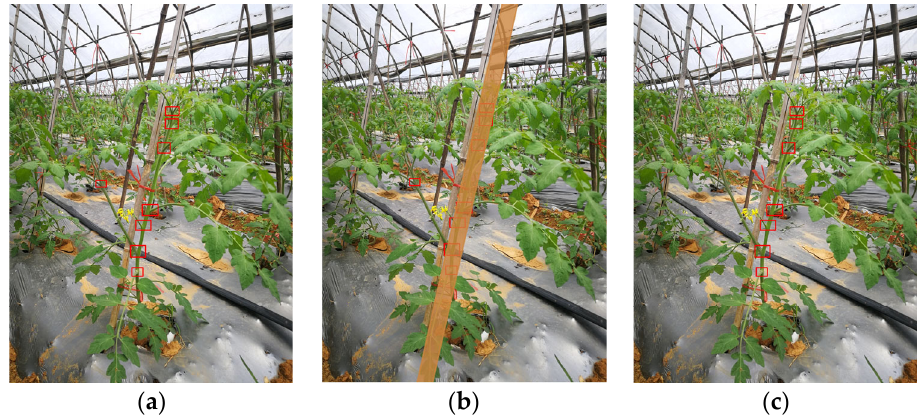
Figure 9. Illustration of the extracted trunk nodes. ( a ) the detected nodes; ( b ) the constructed trunk area; ( c ) nodes within the trunk